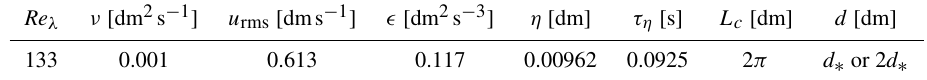
Table 1. Values of the parameters in the DNS. (Note that dm denotes decimeters.) From the left, we have the Taylor-scale Reynolds number, kinematic viscosity of the fluid, root-mean-square of fluid velocity, kinetic energy dissipation rate, Kolmogorov length scale and timescale, length of the simulation cube and particle diameters considered. We have introduced d ∗ to represent the specific value 9 . 49 × 10 − 4 dm (more details in the text). We choose the units of the length scale (timescale) in the DNS to be in decimeters (seconds), such that ν is nearly its typical value in the atmosphere. Re λ ν [dm 2 s − 1 ] u rms [dms − 1 ] 133 0.001 0.613 0.117 0.00962